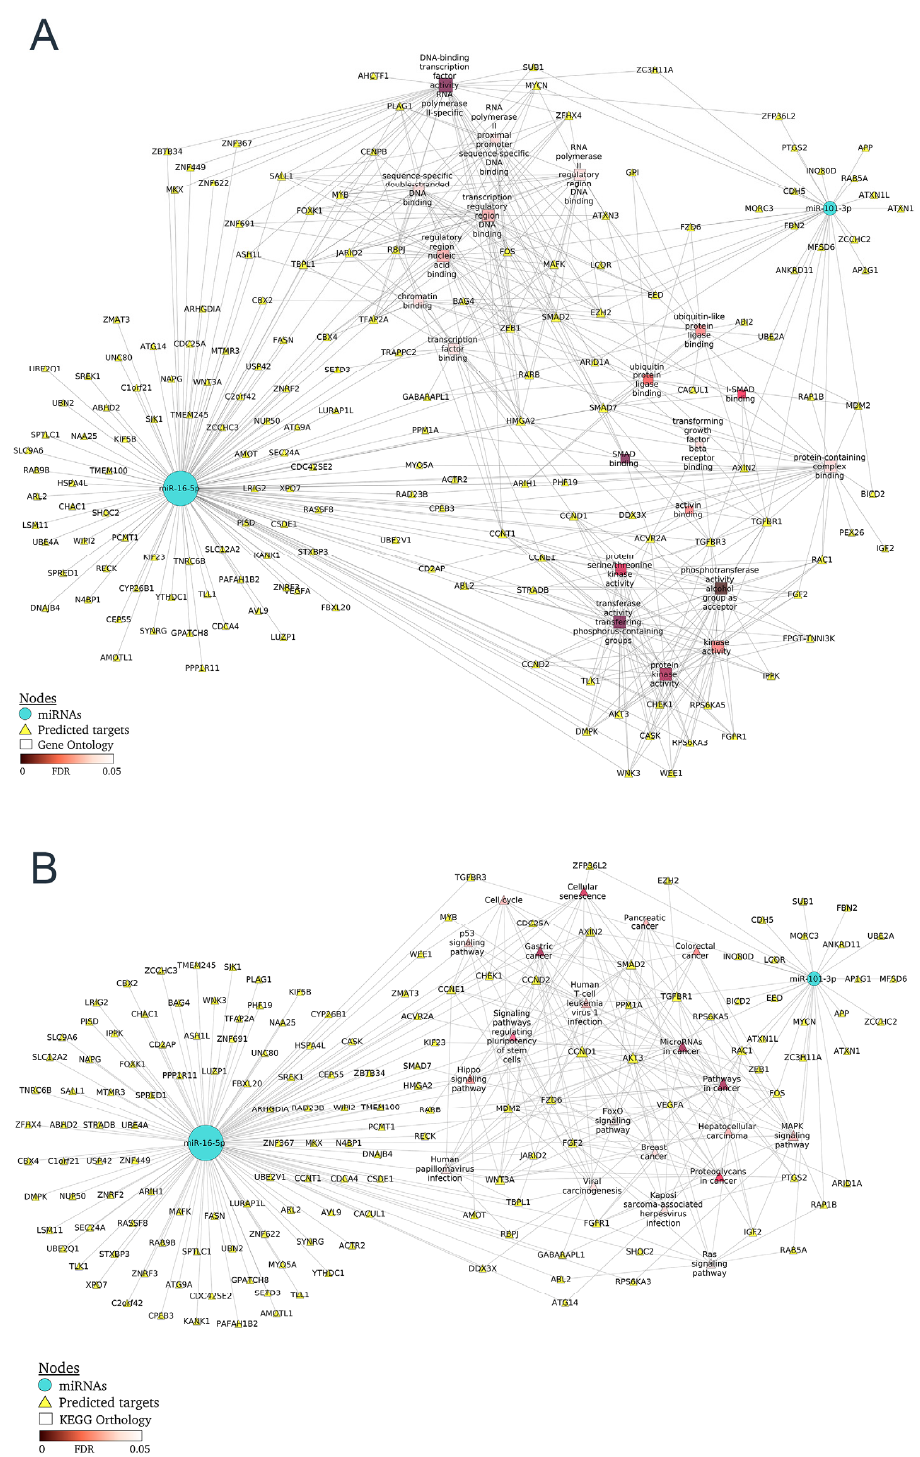
Figure 4. Regulatory networks of miRNAs–mRNAs for exosomal fraction in LN. ( A ) The two miRNAs (miR-16-5p and miR-101-3p) blue circles and their predicted targeted genes (yellow triangles) are shown together with the top 20 GO terms whose color is proportional to the FDR value, and ( B ) the top 20 KEGG pathways.